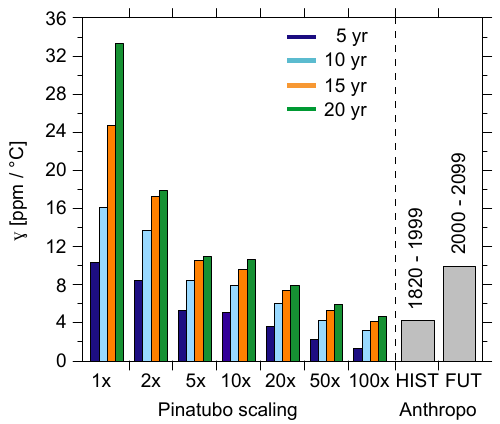
Fig. 4. Estimates of climate-carbon cycle sensitivity γ derived from the Pinatubo scaling experiments (labeled as Pinatubo scaling) and from transient simulations over the period 1820 to 2099 (labeled as Anthropo) with the NCAR CSM1.4-carbon model. Colors indicate the considered time scales, indicated by the labels 5yr, 10yr, 15yr and 20yr. Grey bars show γ ’s calculated from transient simula- tions forced with historical carbon emissions over the period 1820 to 1999 (HIST: 1820–1999) and following the SRES A2 scenario over the period 2000 to 2099 (FUT: 2000–2099),